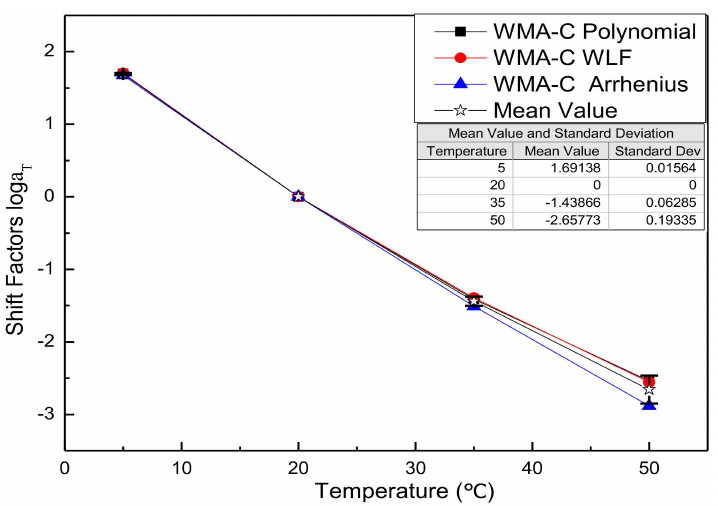
Figure 4. Shift factors of HMA-C.